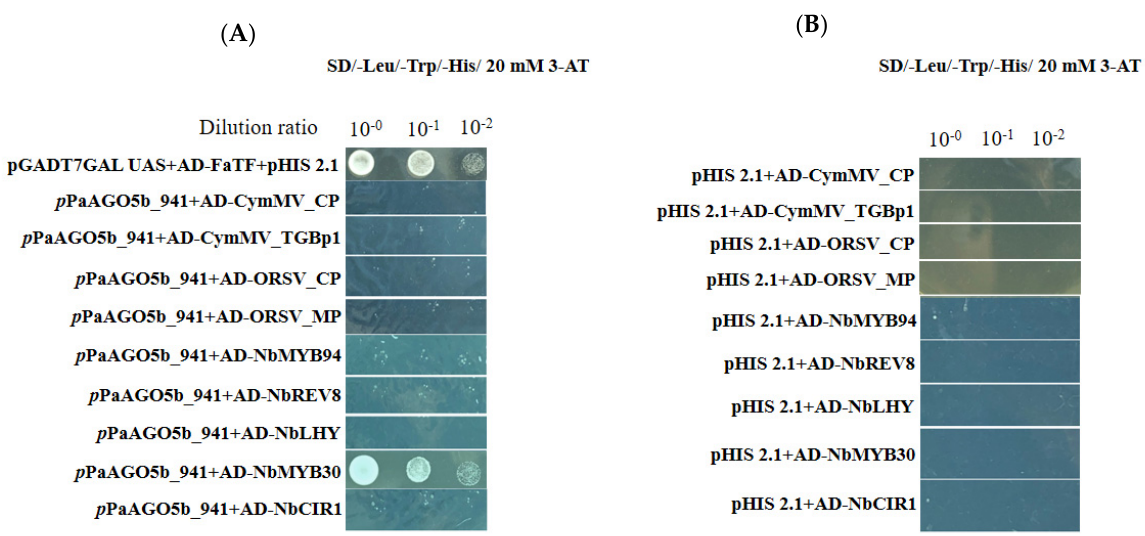
Figure 5. Physical interaction between p PaAGO5b_941 and viral genes or TFs in yeast cells. The full-length clones of CymMV_CP, CymMV_TGBp1, ORSV_CP, ORSV_MP, NbMYB94, NbREV8, NbLHY, NbMYB30, and NbCIR1 and were fused to pGADT74-AD and p PaAGO5b_941 fused to pHIS 2.1-BD were cotransformed and expressed in the yeast strain Y187. The transformed yeast cells were grown in non-selective media with histidine (SD/-Leu/-Trp) (Supplementary Figure S14) or ( A ) selective media without histidine with 20 mM 3-AT (SD/-Leu/-Trp/-His), followed by incubation at 30 ◦ C for 3 days. The pHIS 2.1 vector and pGADT74-AD cotransformed with strawberry heat shock TF (FaTF) fused with pGBKT7 vector into yeast cells were used as the positive control. ( B ) The pHIS 2.1 vector and cotransformed with CymMV_CP, CymMV_TGBp1, ORSV_CP, ORSV_MP, NbMYB94, NbREV8, NbLHY, NbMYB30, and NbCIR1 into yeast cells were used as the negative